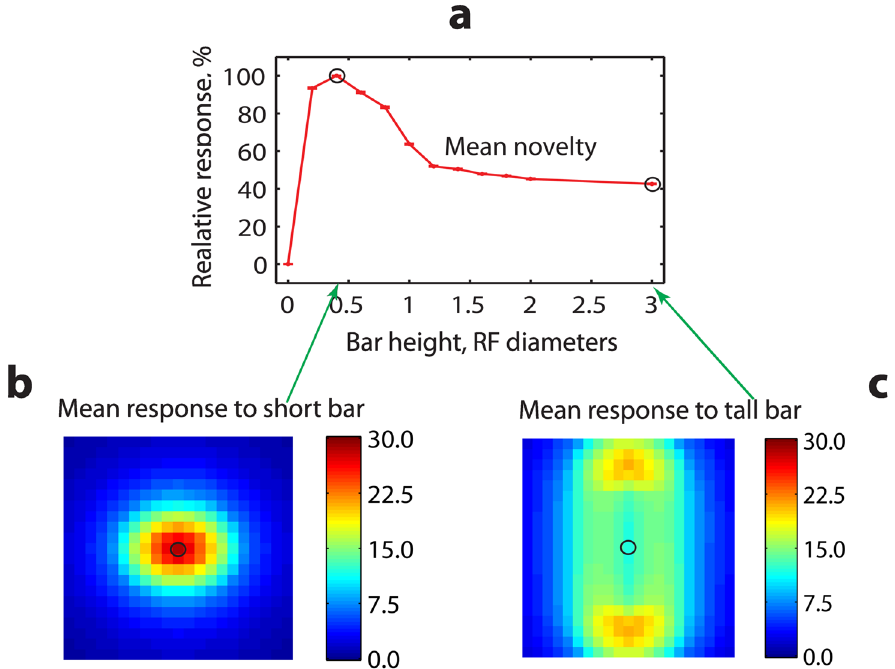
Fig 6. Non-classical effect of endstopping is present in the effectively feedforward architecture of modular predictive coding. a Activity of level-1 novelty neurons averaged across the RF of bar-detecting level-1 familiarity neurons decreases as bar height exceeds approximately one-half of the RF diameter. Activity is shown relative to baseline activity for the short bar of 0.4 RF diameter and five times brighter than the background. Black circles indicate the responses of bar detectors relative to the baseline for short and tall bars in panels b and c, respectively. b Average activities of level-1 novelty neurons in a neighborhood of 3.5-by-3.5 RF diameters around each bar-detector in response to the short bar. Central dark red square (black circle) represents the average activity of all novelty cells within the RF of a bar detector, further averaged across all bar detectors. The same double averaging was applied to the novelty neurons within the RFs of the neighboring familiarity neurons. While these RFs are highly overlapping, they are displayed here side-by-side. c Same as in panel b, but in response to a tall bar of height 3 (instead of 0.4) RF diameters. The averaged activity of novelty neurons (representing the local reconstruction error) within the bar-detectors RF (black circle) is lower than that for the short bar (compare black circles) and for the same reason also lower than that recorded at the ends of the bar (top and bottom yellow